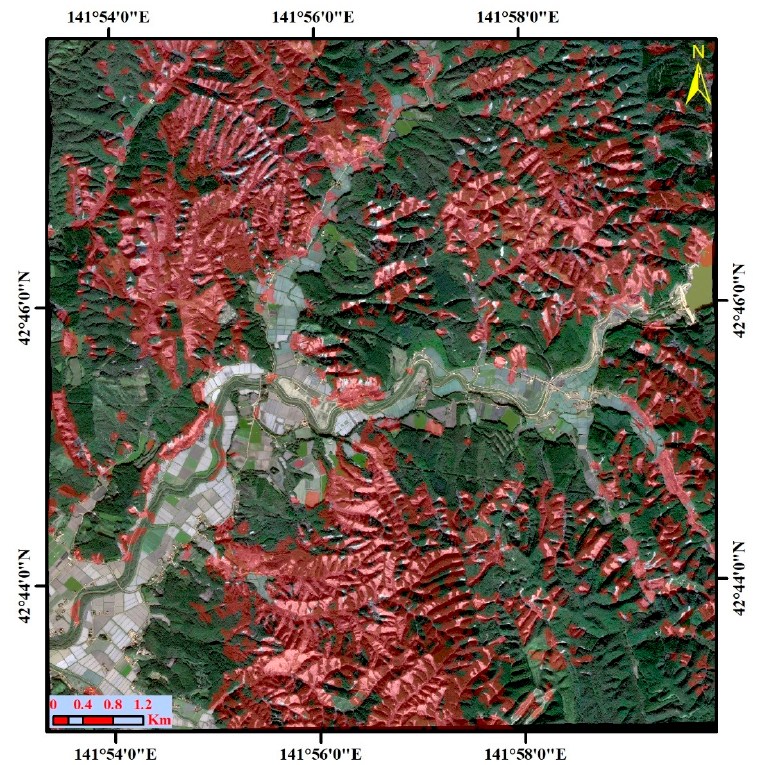
Figure 11. The landslide classification map using both coherence and intensity difference in descending SAR images (case 3). The background is a GeoEye-1 image taken on 20 October 2018.